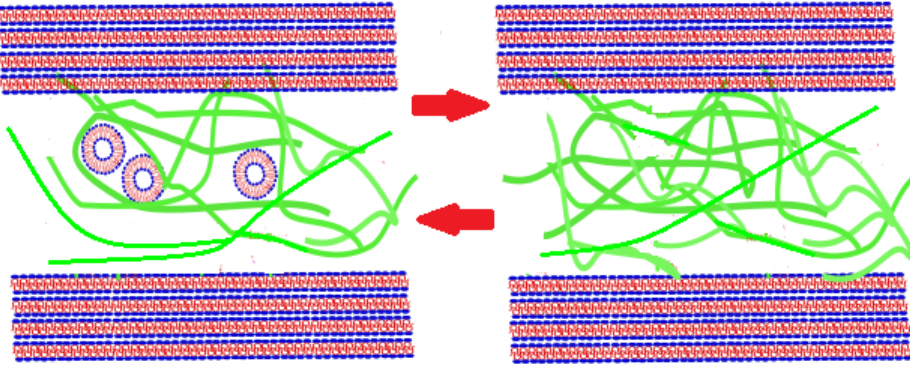
Figure 1. Artistic depiction of simplified composition articular cartilage in synovial joint organ system at different levels of functionality. The articular cartilage surfaces are depicted as multilamellar bilayers of the surface active phospholipid layer without the underlying cartilage zones. Micellar structures are shown between the articulating surfaces in various states of micellization and hyaluronan is shown as molecular chains (green) in various states of crosslinking and network formation. Donut-like structures represent PL vesicles. PL can create cylinder like structures surrounding HA chains and form more complex networks. Lubricin, water and other SF components have not been depicted in the